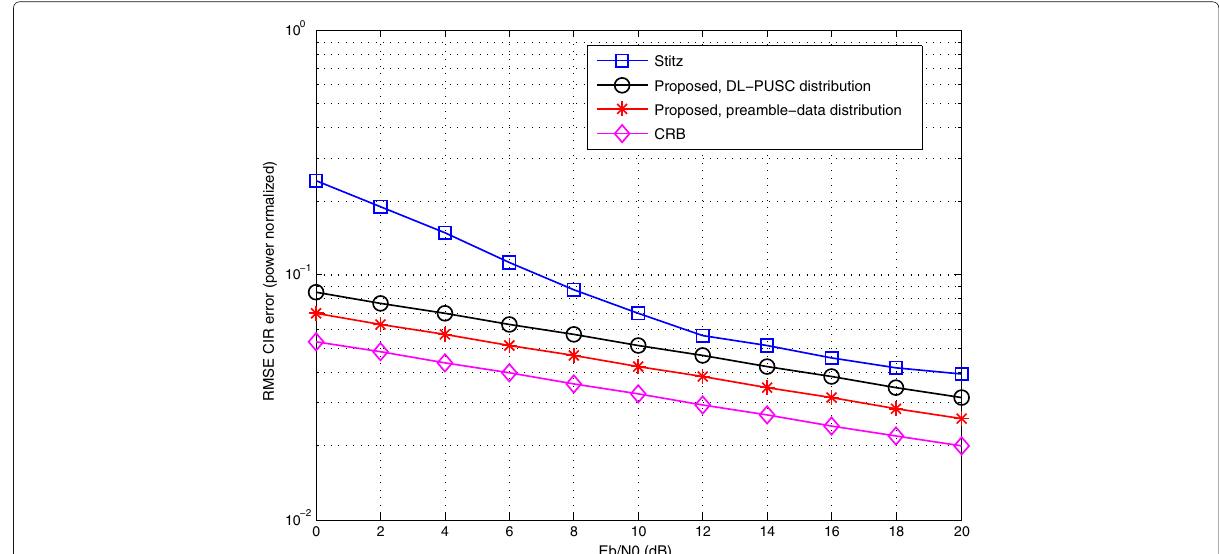
Fig. 6 Comparative RMSE error of channel estimation versus input E b / N 0 with CFO = 5% and STO =